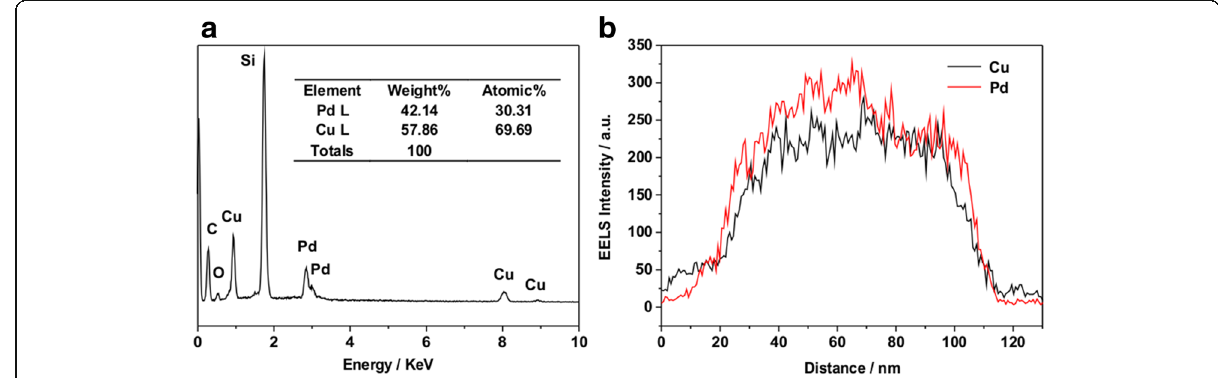
Fig. 2 EDX spectra ( a ) and STEM-EDS profiles ( b ) of Pd-Cu (F) /RGO. The Si peak came from the necessary Si